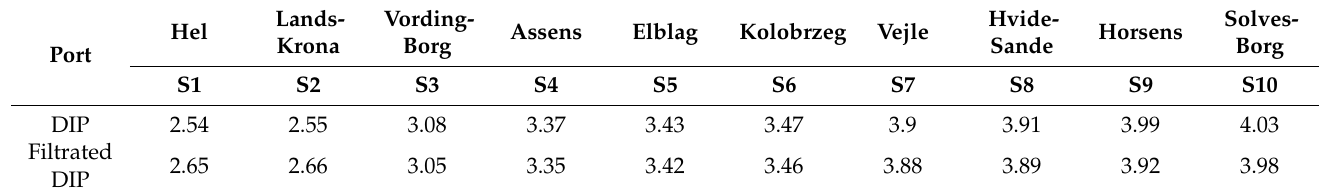
Table 4. DIP score values calculated for small